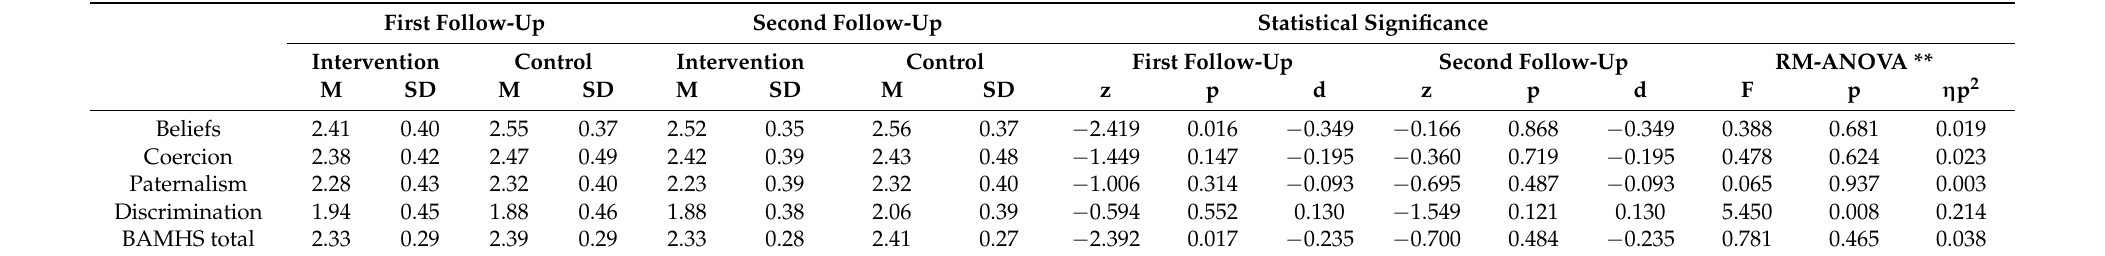
Table 4. Follow-up scores among mental health participants (raw data